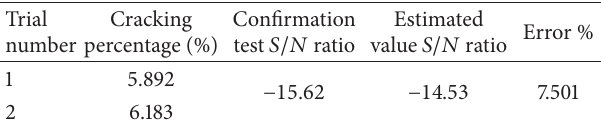
Table 7: Confirmation test